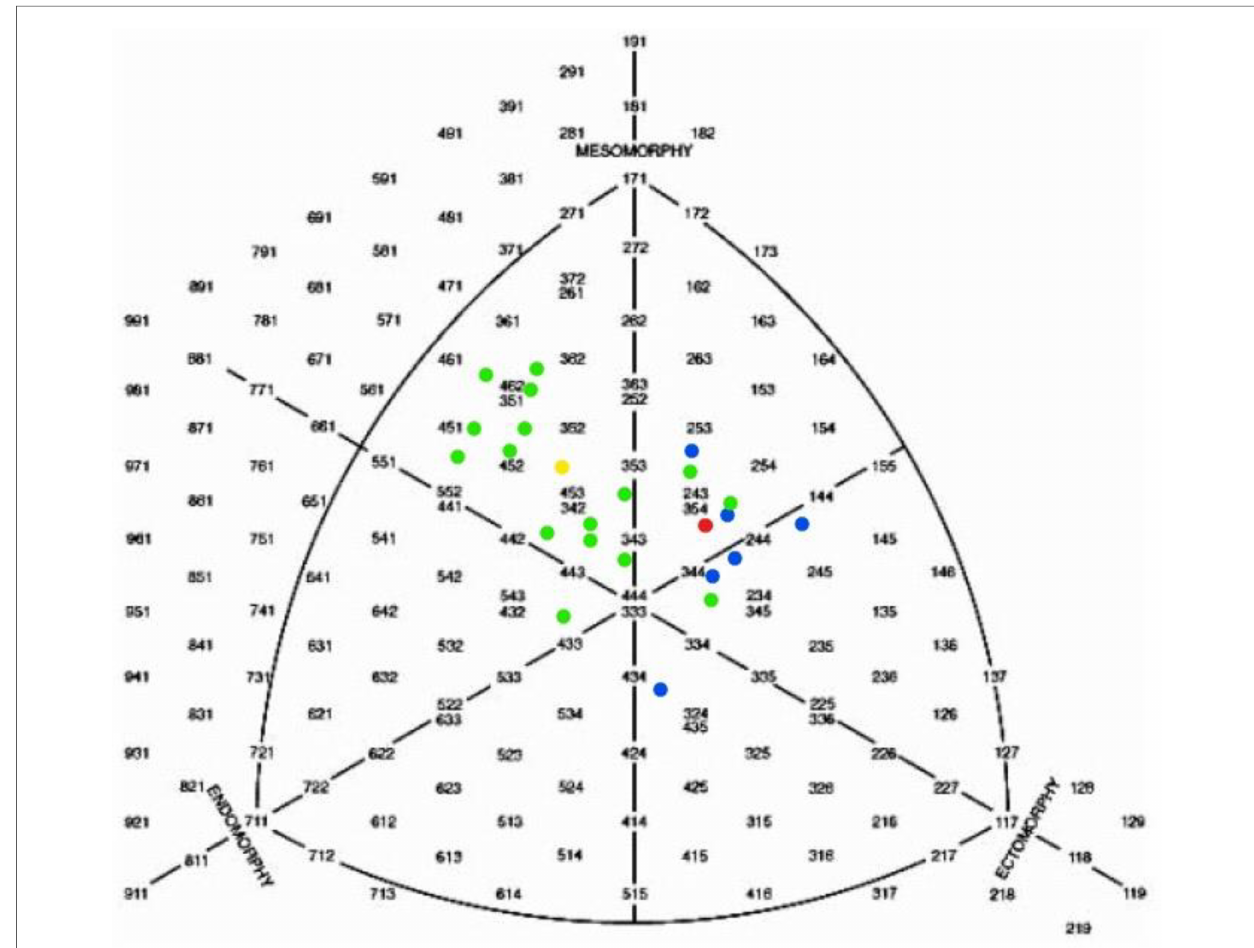
FIGURE 2 Somatograph of female rowers: ● individual somatotype of heavyweight rowers; ● average somatotype of heavyweight rowers (3.1 – 4.4 – 2.1); ● individual somatotype of lightweight rowers; ● average somatotype of lightweight rowers (2.0 – 3.7 –